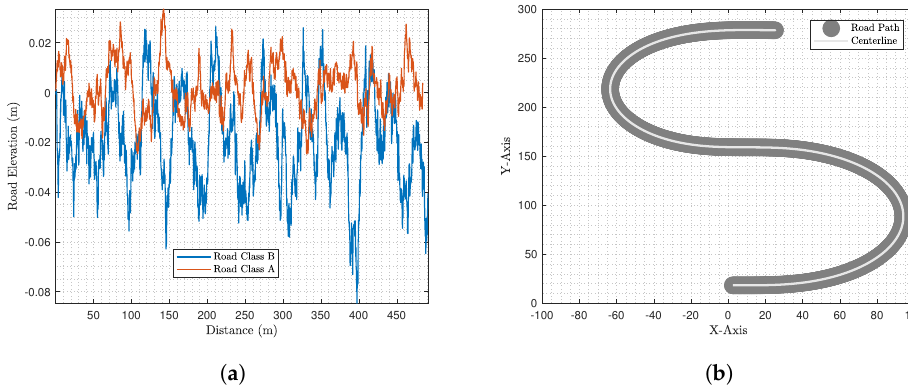
Figure 5. ( a ) Class A and B road profiles assigned on the ( b ) road